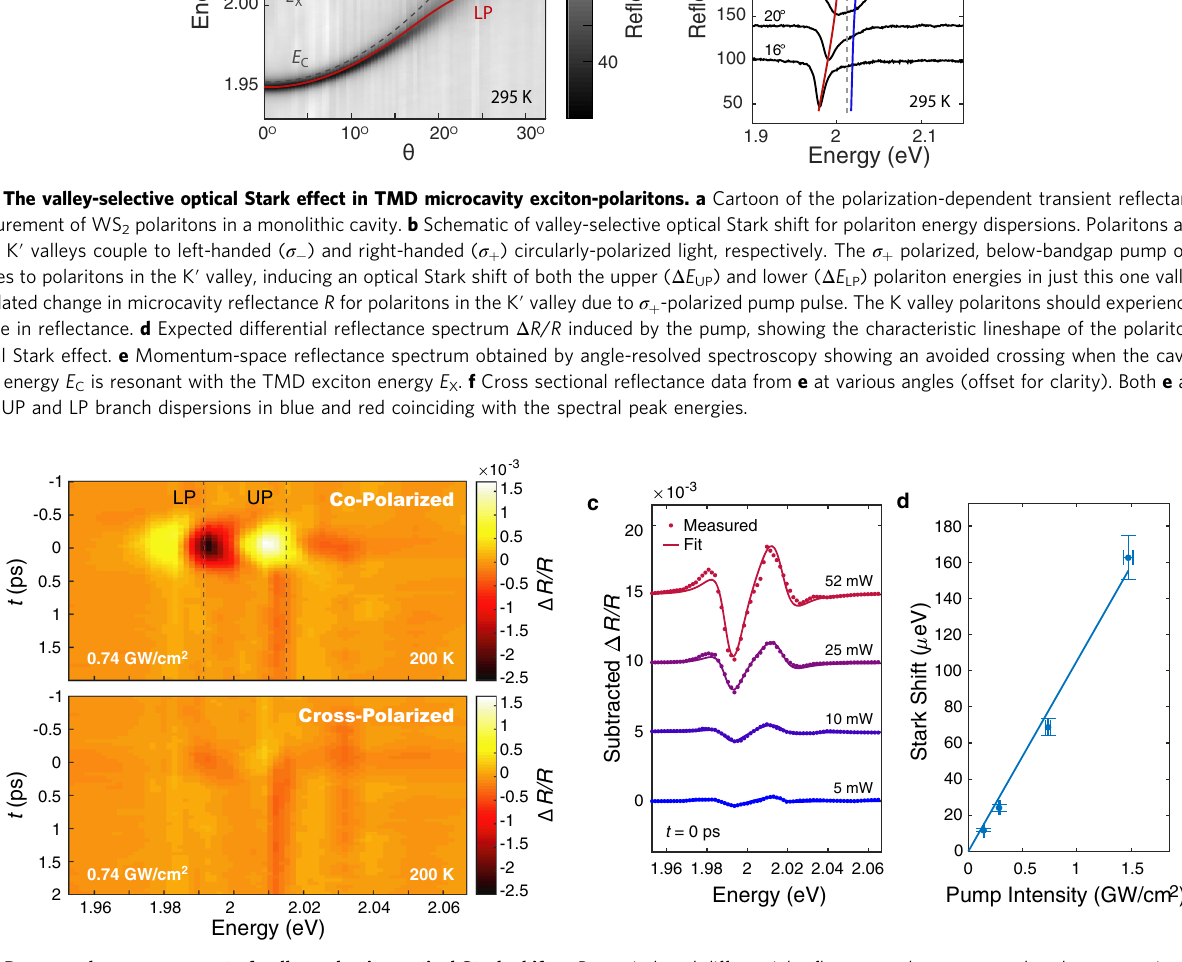
Fig. 2 Pump-probe measurement of valley-selective optical Stark shift. a Pump-induced differential re fl ectance when pump and probe are co-circularly polarized. The sharp signal at t = 0 is attributed to a optical Stark shift of both upper and lower polaritons. b Differential re fl ectance when pump and probe are cross-polarized, lacking sharp signal at t = 0. c Background-subtracted Δ R / R signal at zero delay for increasing pump intensities (dots) and fi ts (solid) to a transfer matrix model. d Stark shift magnitude extracted from fi ts to data in c showing expected linear trend. Error bars in pump intensity represent uncertainty in the measured pump power and spot size. Error bars in Stark shift magnitude represent uncertainty from the fi t procedure (see Supplementary